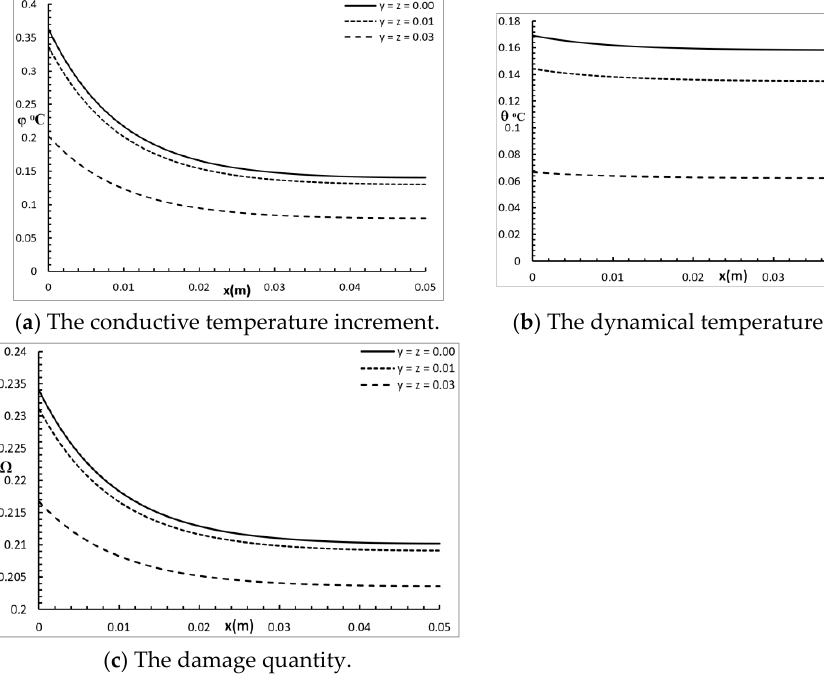
Figure 2. The studied functions at various positions along the axes.